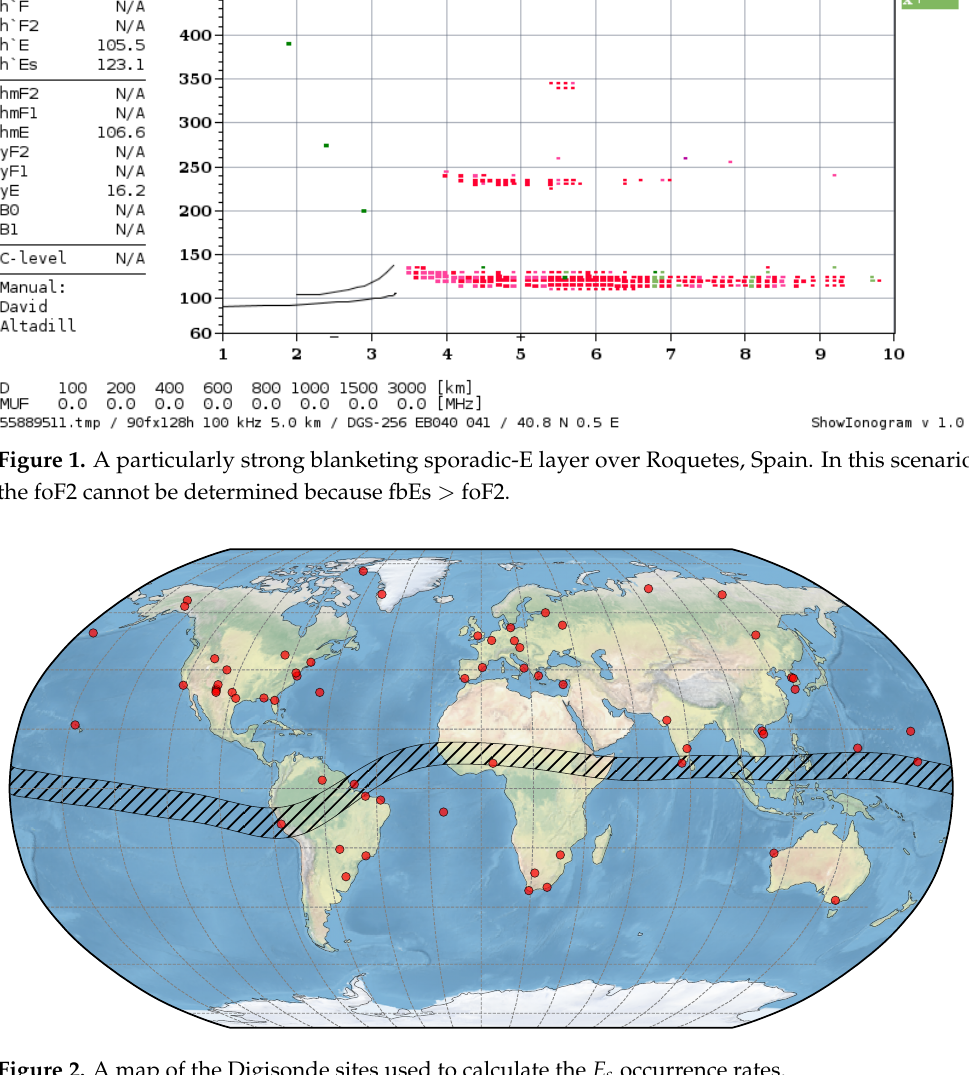
Figure 2. A map of the Digisonde sites used to calculate the E s occurrence